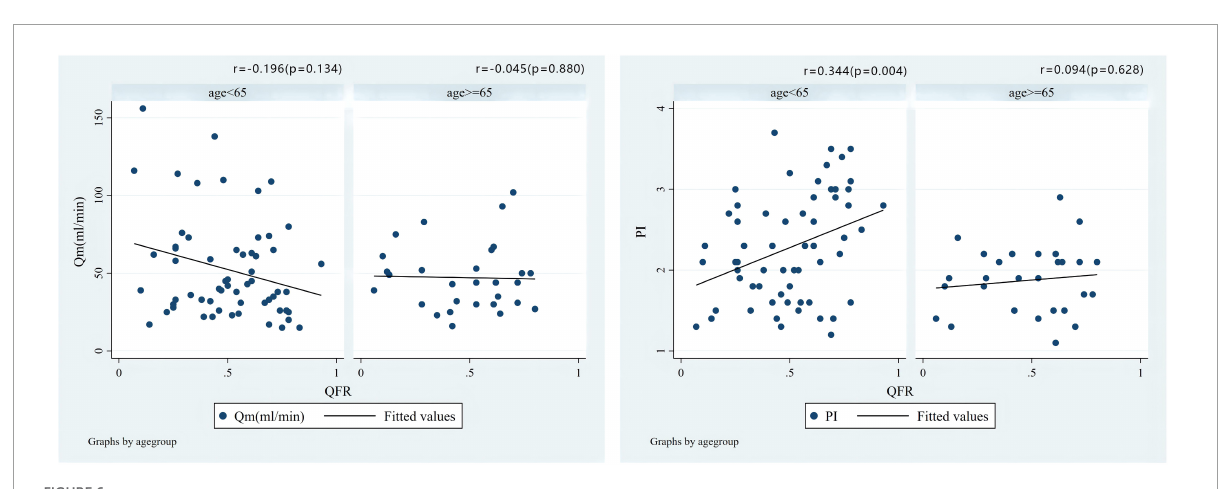
FIGURE6 Correlations of the preoperative QFR of the LAD and the parameters of intraoperative TTFM of the in situ LITA graft to the LAD, including Qm and PI in different age